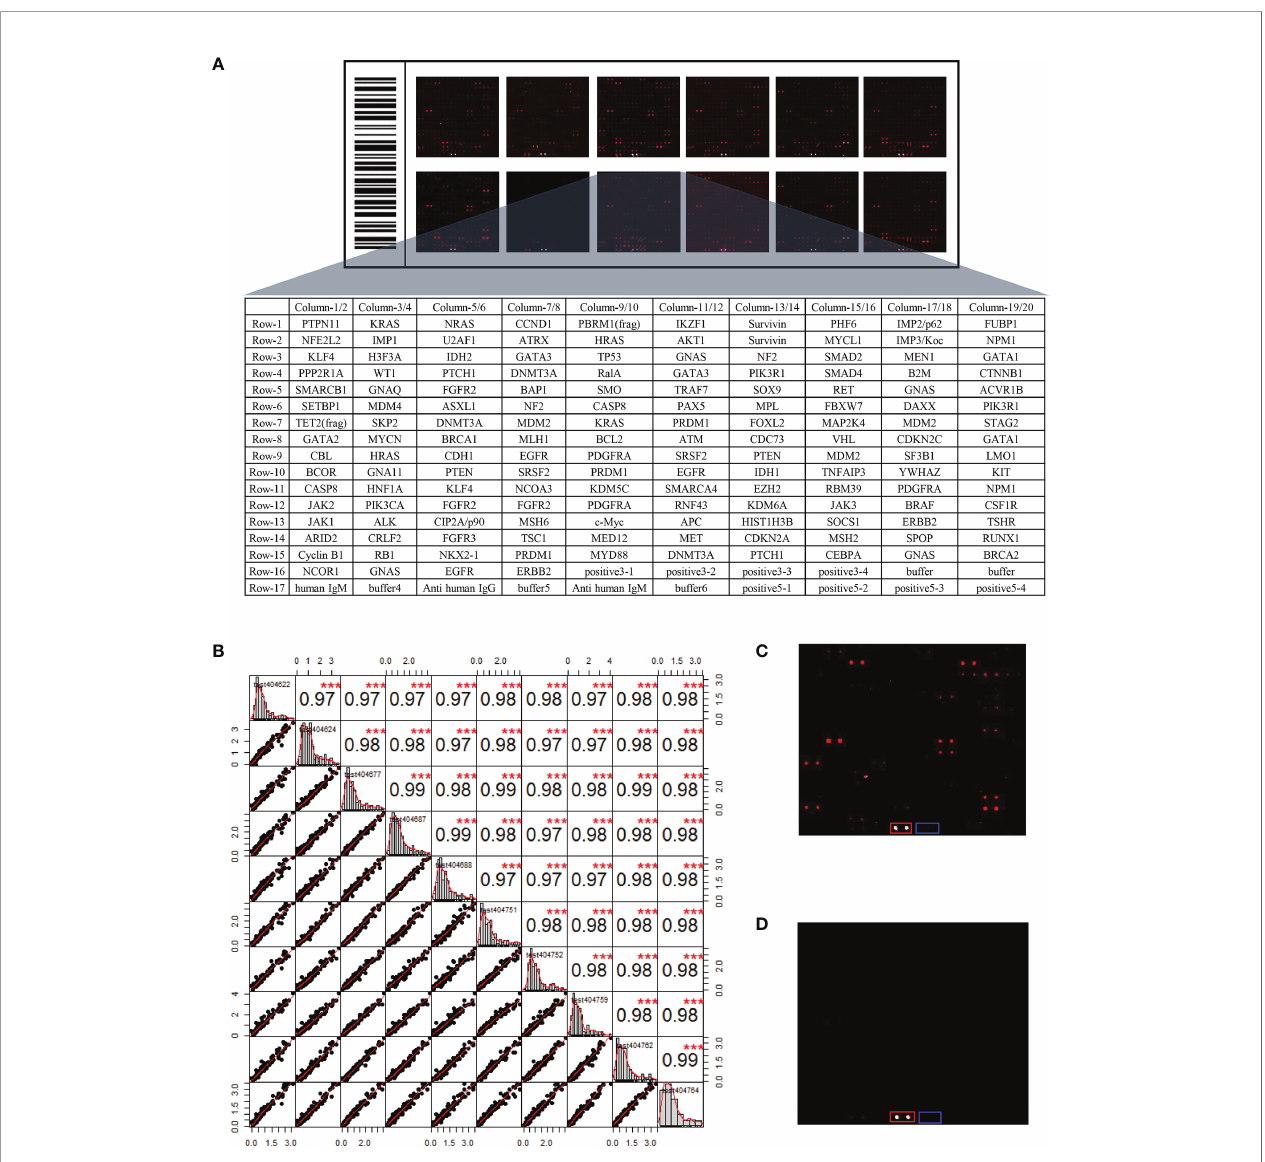
FIGURE 2 | (A) Layout of the customized protein array. (B) Evaluation of the operational stability of different chips at different time points. The top right half represents the correlation results between samples after linear fi tting (*** p < 0.001), while the bottom left half depicts the distribution of the results after linear fi tting. (C) Protein fl uorescence quanti fi cation results of a LUAD sample. (D) Protein fl uorescence quanti fi cation results of a NC sample [ red and blue frames highlight the positive control (anti-human IgM) and negative control (buffer)]. LUAD, lung adenocarcinoma; NC, normal